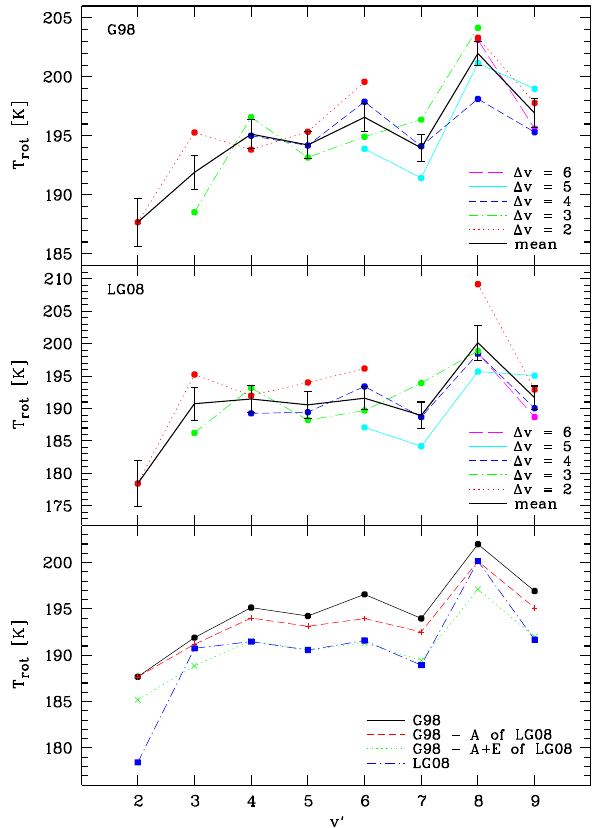
Figure 6. Rotational temperature T rot as a function of v (cid:48) . The filled circles in the upper and middle panel show the line-set-corrected T rot of the investigated 25 OH bands for the G98 and LG08 line parameters, respectively. T rot for bands with the same vibrational level difference (cid:49)v = v (cid:48) − v (cid:48)(cid:48) are marked by different connecting lines (see legend). The averages of the T rot for bands with the same v (cid:48) are connected by a black line, which also show the mean errors derived from the T rot variation for a given v (cid:48) and the individual T rot measurement uncertainties. The lower panel exhibits the influence of the line parameters on T rot (v (cid:48) ) . Here, the results for the G98 data (black solid line), G98 data with the Einstein coefficients of LG08 (red dashed line), LG08 data with the atmospheric transmission cor- rection and line integration wavelength ranges for G98 data (green dotted line), and the LG08 data (blue dash-dotted line) are shown (see also